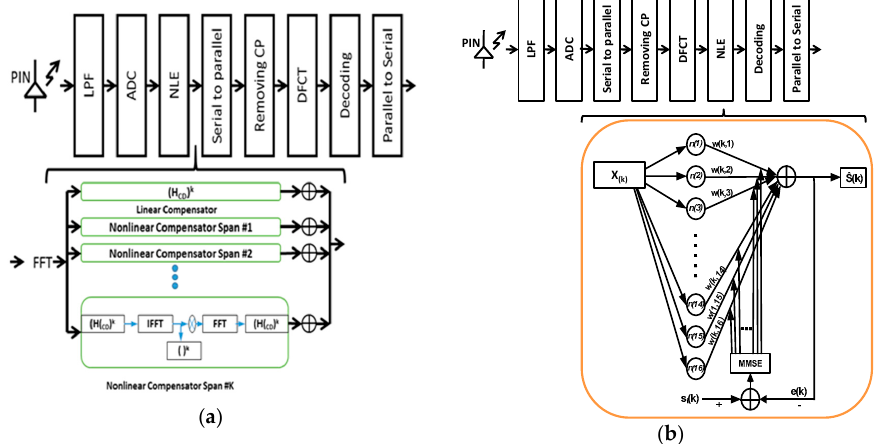
Figure 2. ( a ) Optical Fast-OFDM received diagram showing the equalizer that is based on IVSTF [11]. ( b ) 16-ASK optical Fast-OFDM received diagram illustrating the ANN sub-neural network equalizer. LPF: low-pass filter; ADC: analogue-to-digital converter; CP: cyclic prefix; DCT: Discrete-Cosine Transform; NLE: nonlinear equalizer; ANN: artificial neural network; n: neuron; MMSE: minimum mean square error; HCD: nonlinear system chromatic dispersion.